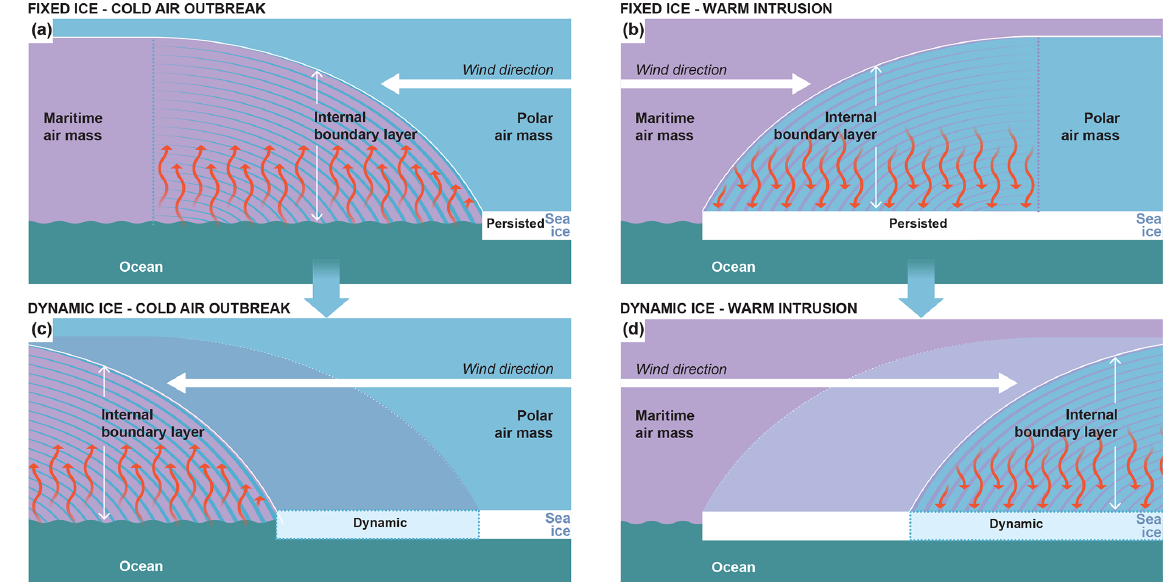
Figure 8. Schematic showing the of impact of dynamic sea ice on turbulent exchange and atmospheric boundary layer development during cold-air outbreaks ( a , c ) and moist intrusions ( b , d